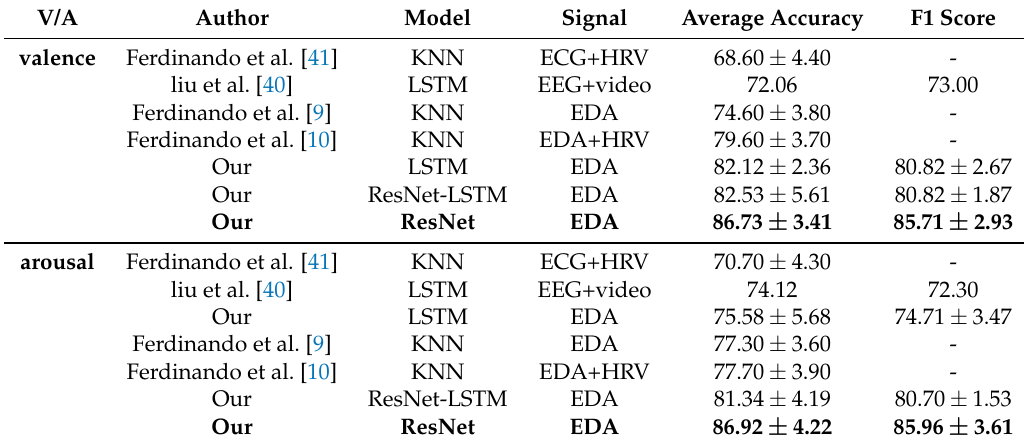
Table 10. Comparison with the state-of-the-art three-class classification tasks in the MAHNOB-HCI dataset. Accuracies (%) and F1 score (%) are subject to 10-fold cross validation. The best results are highlighted in